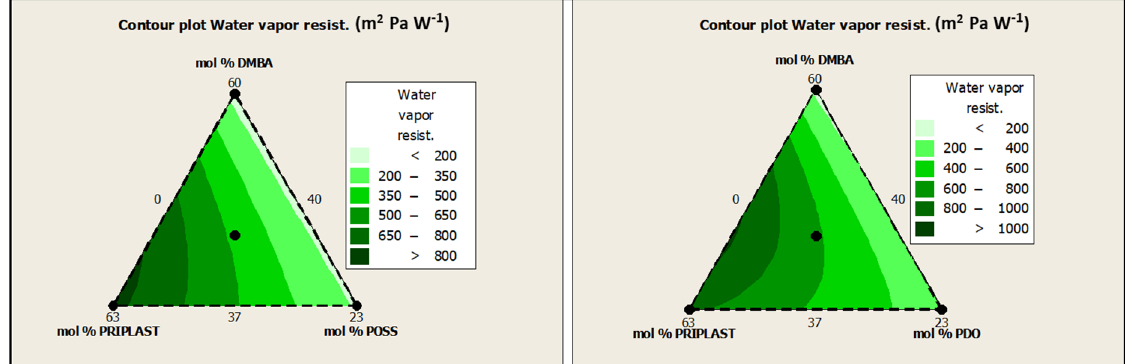
Figure 17. Contour plots of R et for experimental design with POSS-OH ( left ) and experimental design with PDO ( right ).